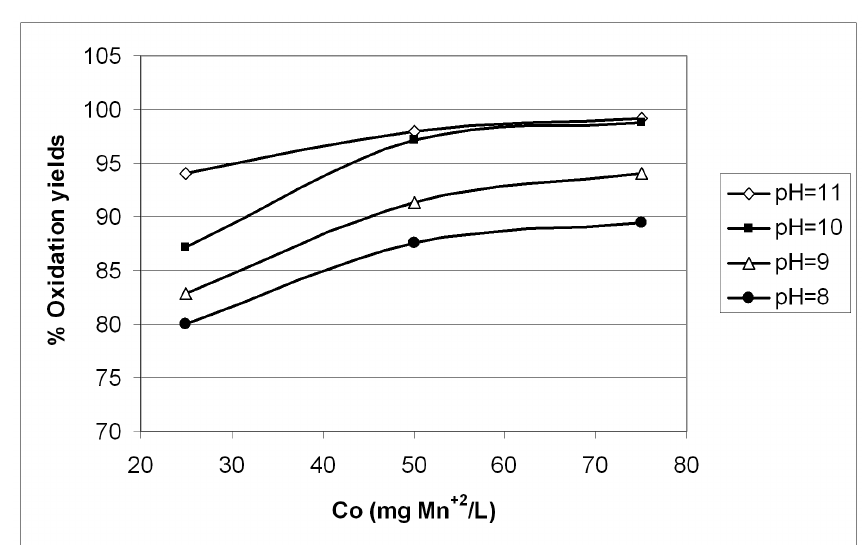
Fig. 4 Oxidation yields as a function of pH and concentration (20 ◦ C, solution with glass beads and 0.5 g MnO 2 ).